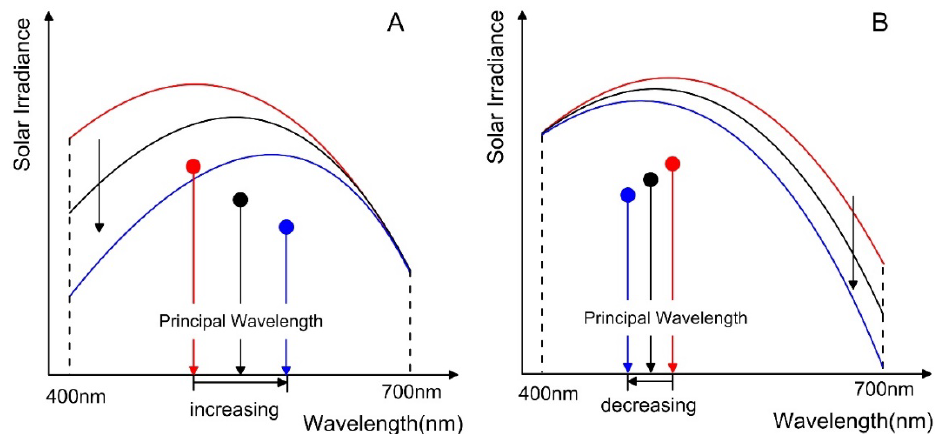
Figure 2. Sketches for the change in the principal wavelength. The original solar spectrum is shown by the red line. The solar spectrum changes after passing through two types of attenuation particles, ( A ) and ( B ), and becomes the black and blue lines depicting the entering solar spectrum. The “weight center” of the red, black, and blue lines is represented by the red, black, and blue points, respectively. The value of the principal wavelength is determined by the placements of their “weight centers” on the wavelength axis.